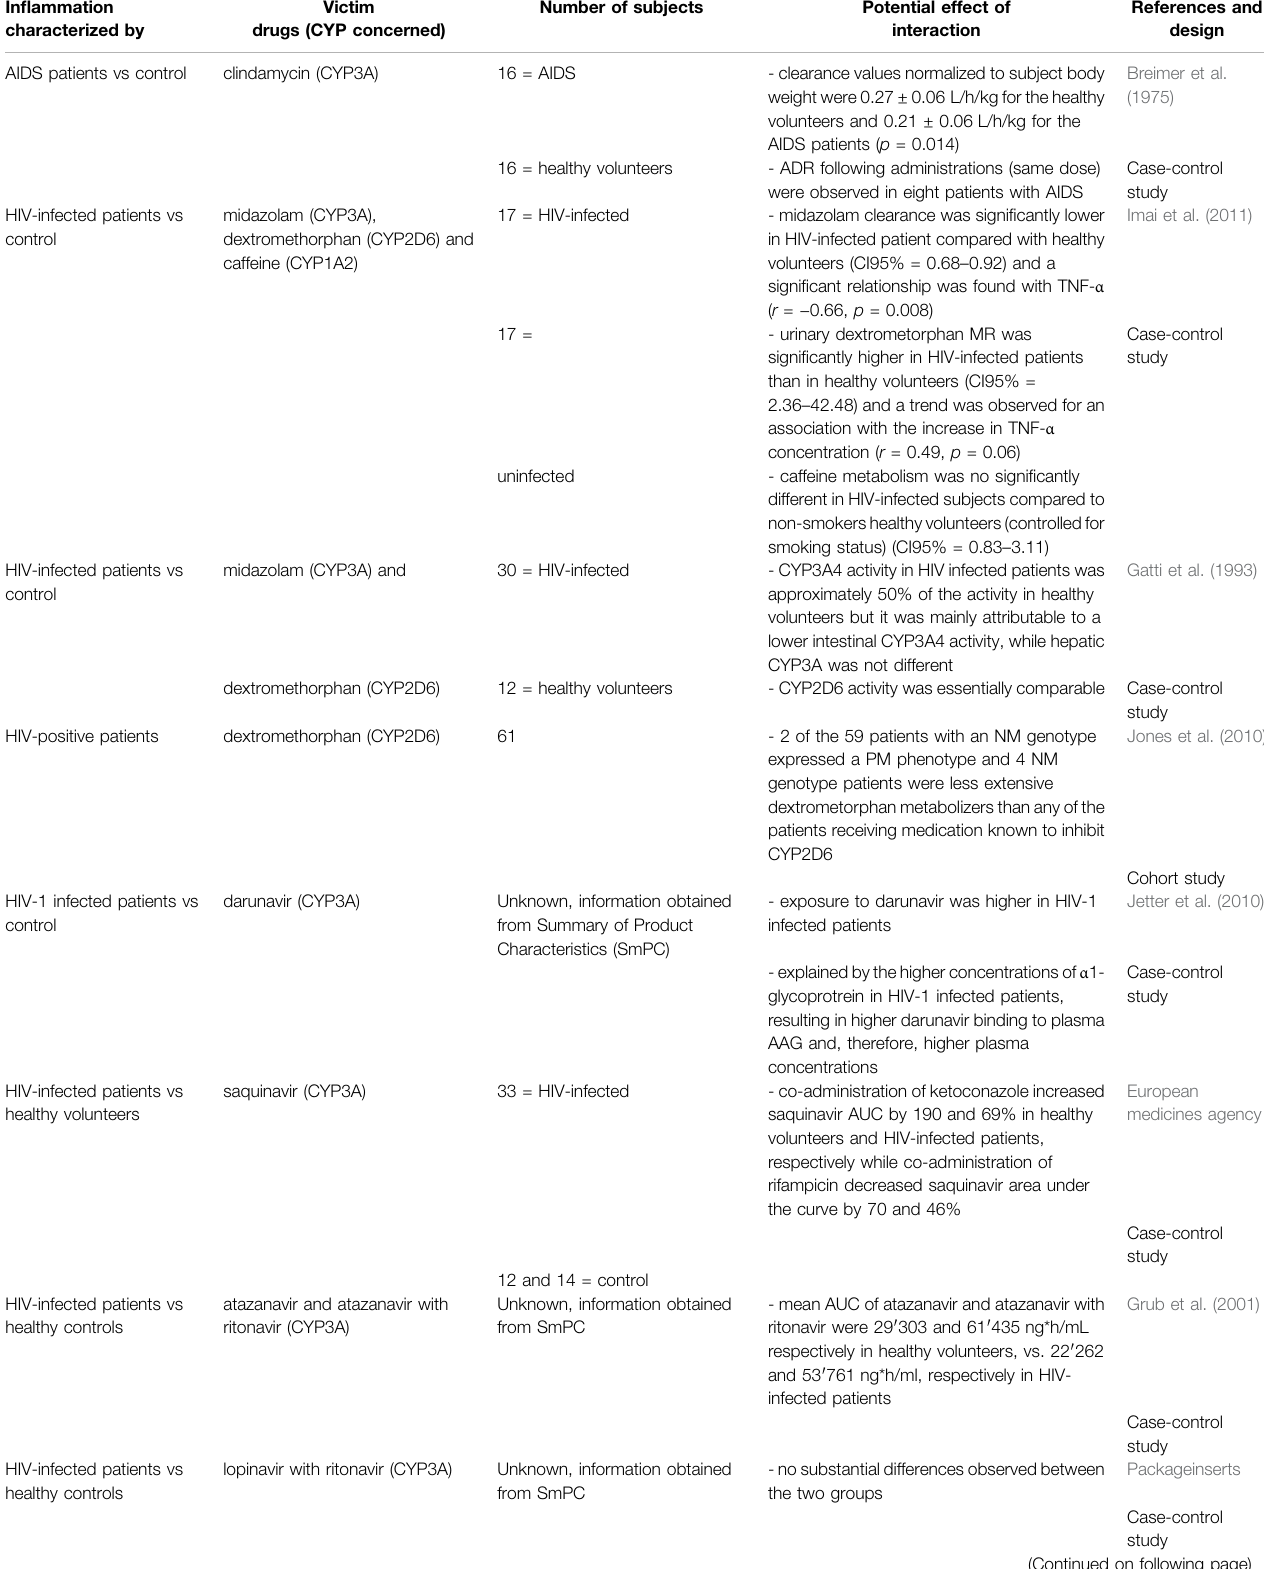
TABLE 3C | Impact of HIV on CYP substrates, explained totally or partially by modulation of CYP activity. In fl ammation characterized